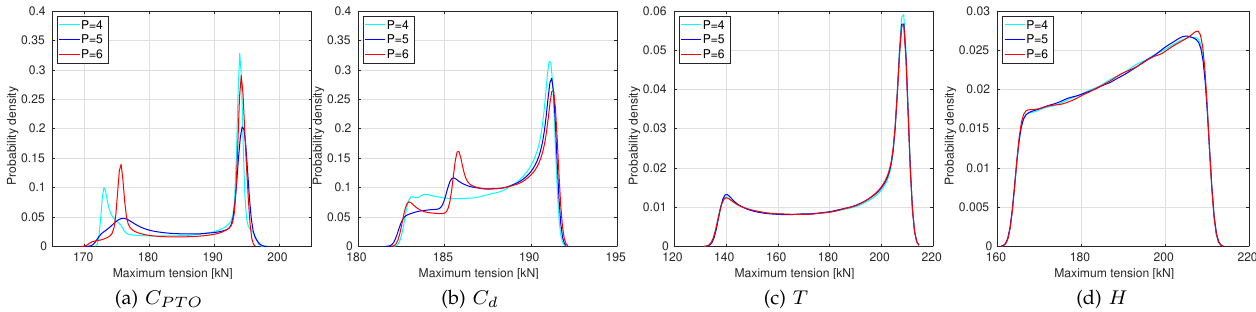
Fig. 6. Convergence of PDFs for the maximum tension in the mooring cable at the fairlead. ERW1 case using d = 1